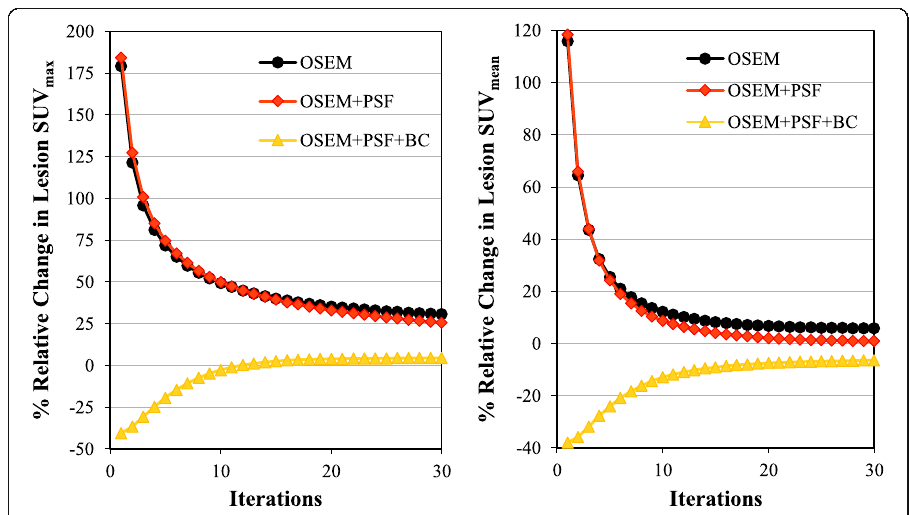
10 mm with a 4-mm Gaussian